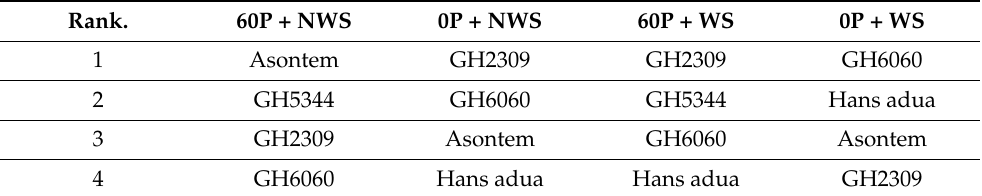
Table 6. Summary of genotypes with highest grain yield subjected to different treatments during two seasons (60P (60 kg P ha − 1 ), WS, water stress over two weeks after 21 DAS and flowering; NWS, no water stress, i.e., optimum irrigation. Rank.